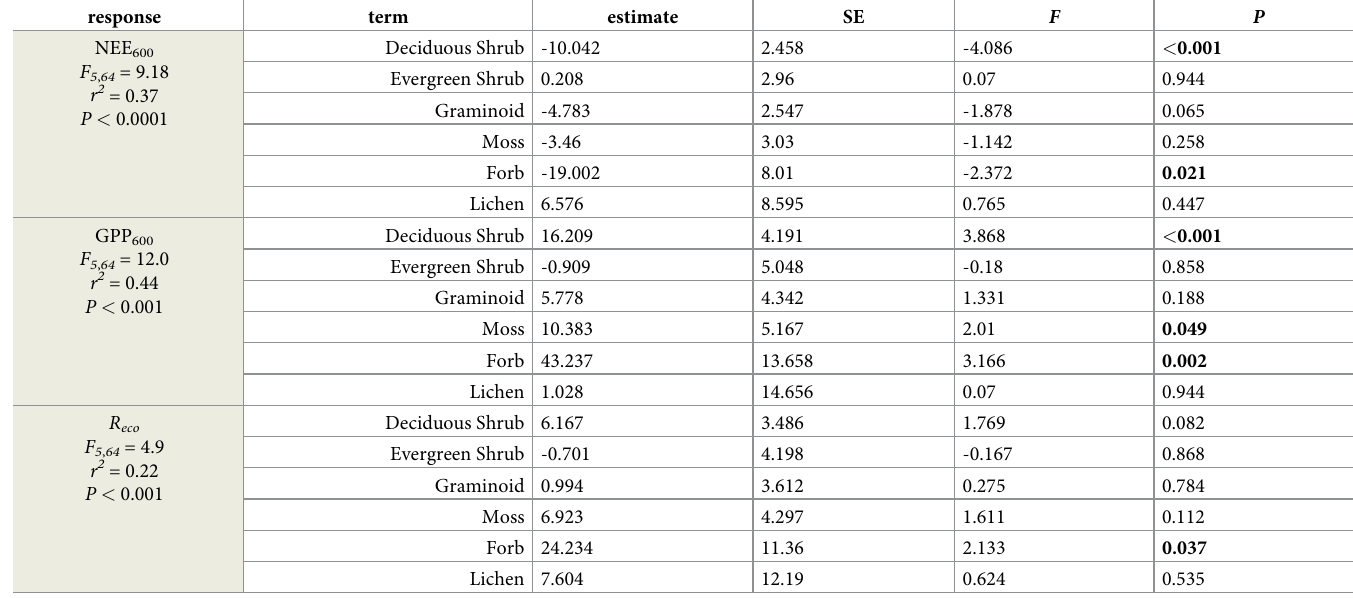
Table 3. Summary of regression models examining the influence of plant functional type top cover (proportion of first pin hits) on plot-level CO 2 exchange. response